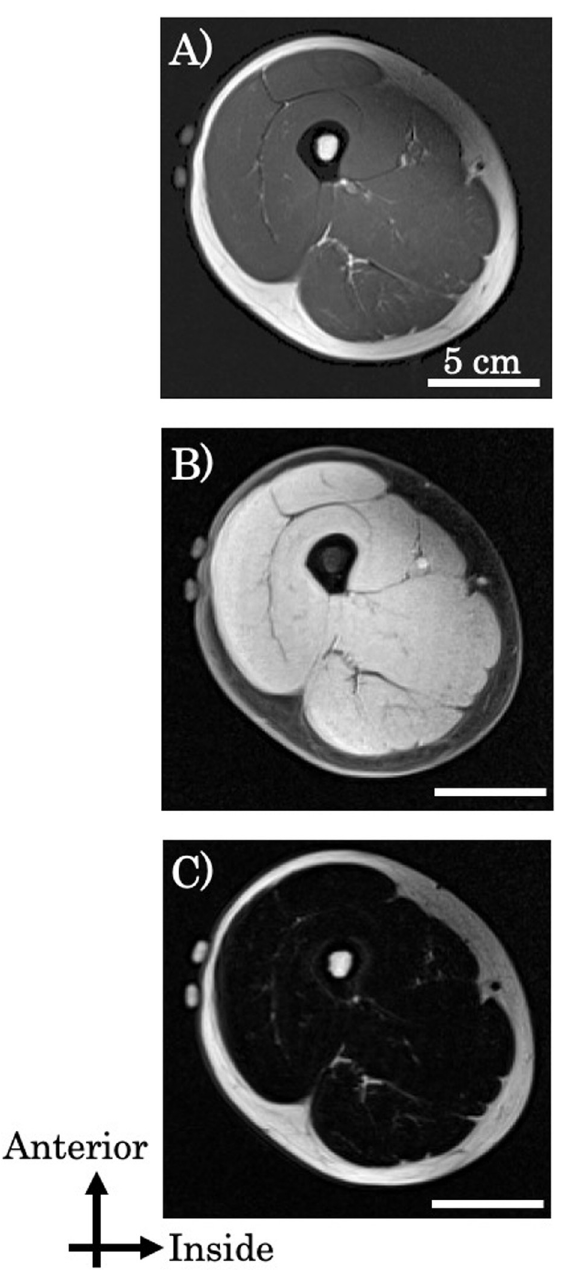
Fig 1. Representative T1-weighted (T1W) image (A) and 2-point Dixon (2PD) images of water (B) and fat (C). 1) T1-weighted images. We used the Medical Image Processing, Analysis and Visualiza- tion software (version 4.4.0; National Institutes of Health, Bethesda, MD) to analyze images on a personal computer. The MRI data analysis procedure was essentially the same as described in previously studies [13–15]. Briefly, we first corrected for image heterogeneity caused by sub- optimal radiofrequency coil uniformity, or gradient-driven eddy currents, using a well-estab- lished nonparametric nonuniform intensity normalization (N3) algorithm [14, 16, 26]. This step was essential for subsequent analyses that assume homogenous signal intensities across